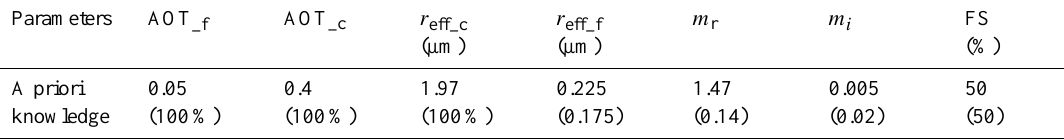
Table 1. A priori knowledge of the aerosol parameters and associated uncertainties.